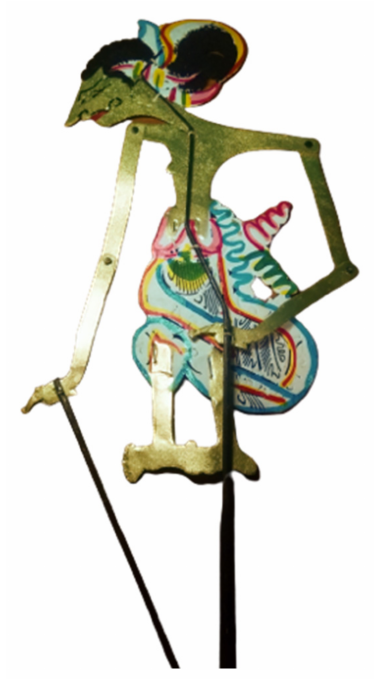
Figure 3. Puntadewa or